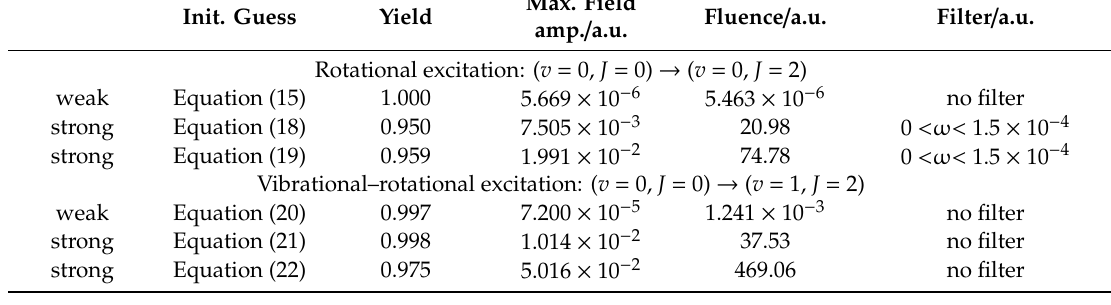
Table 2. Properties of the resultant optimal electric fields. Max. Field Init. Guess Yield amp. / a.u.